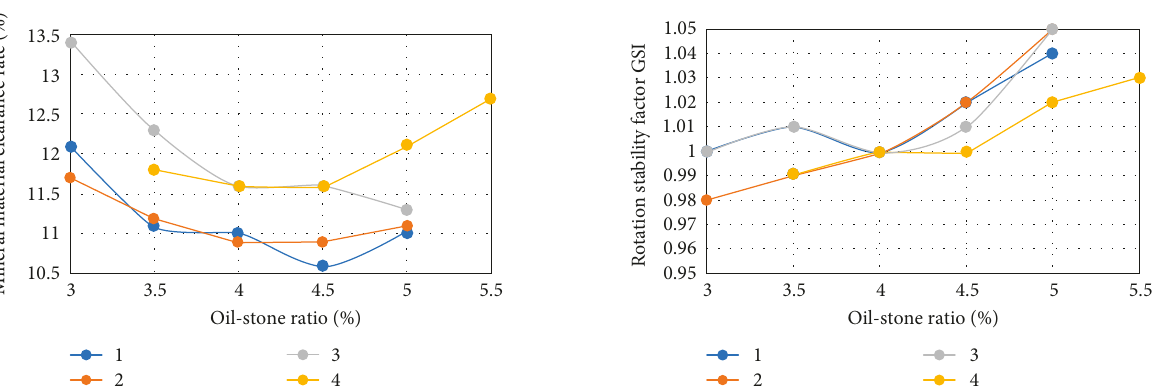
Figure 6: Relation between AC-16 rotation stability factor and oil-